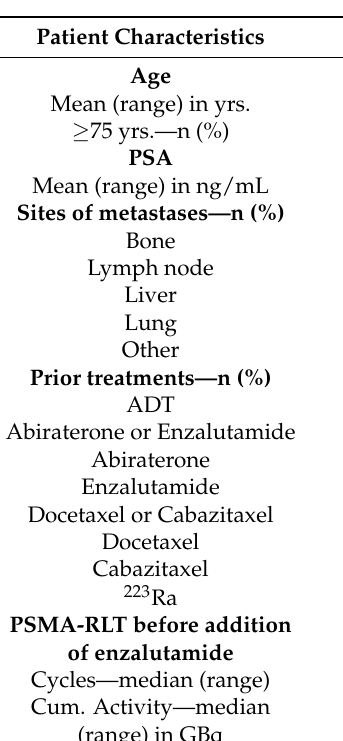
Table 1. Patient